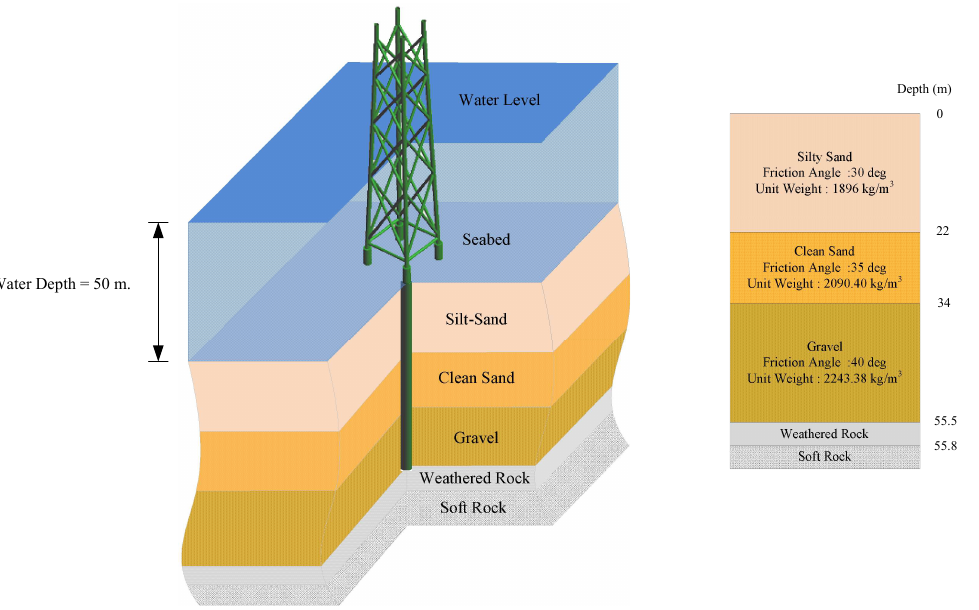
Figure 13. The jacket support structure with the pile-soil-structure interaction (PSSI) model.